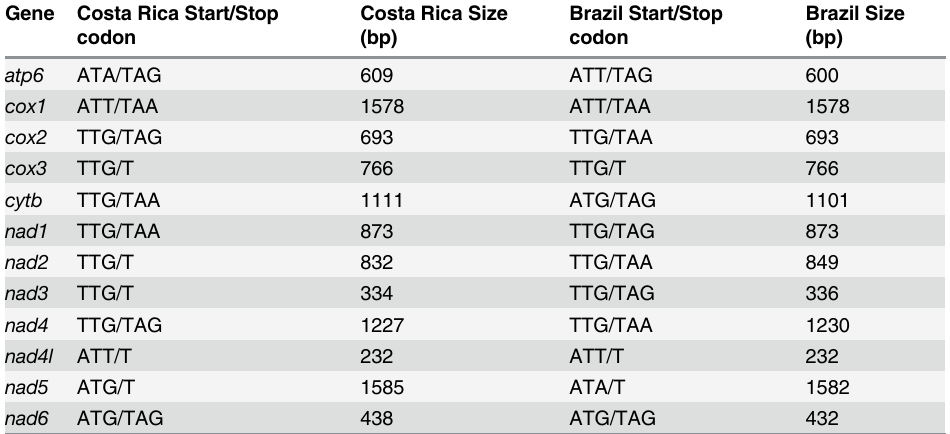
Table 5. Start and stop codons and size of mitochondrial protein-coding genes of Brazil (NC_013067) and Costa Rica taxa of Angiostrongylus costaricensis . Gene Costa Rica Start/Stop Costa Rica Size codon (bp)